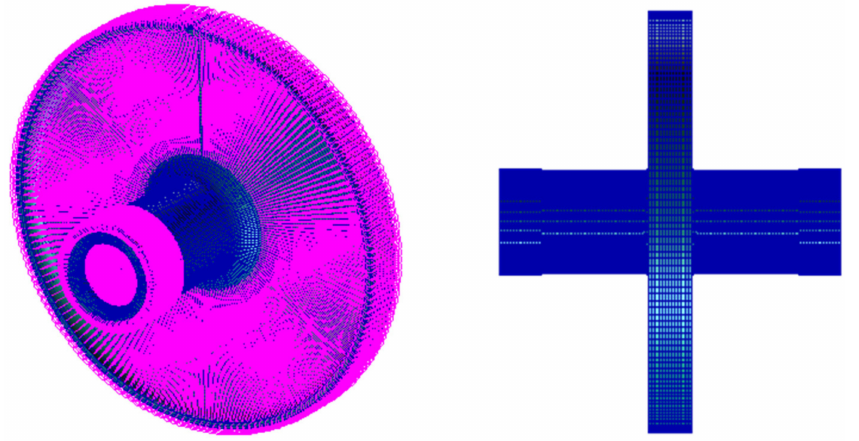
Figure 3. FE model of a gear and shaft assembly, in purple the 3 RBE2 that connect the peripherical nodes of the bearing locations and base circle to the master